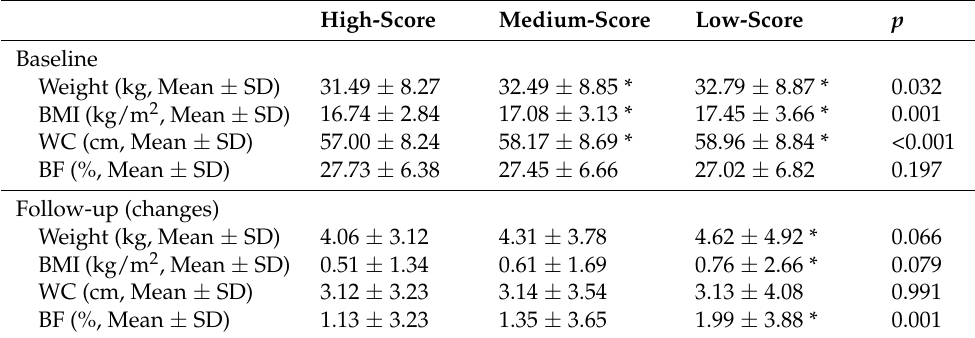
Table 2. Physical measurements at baseline and follow-up.